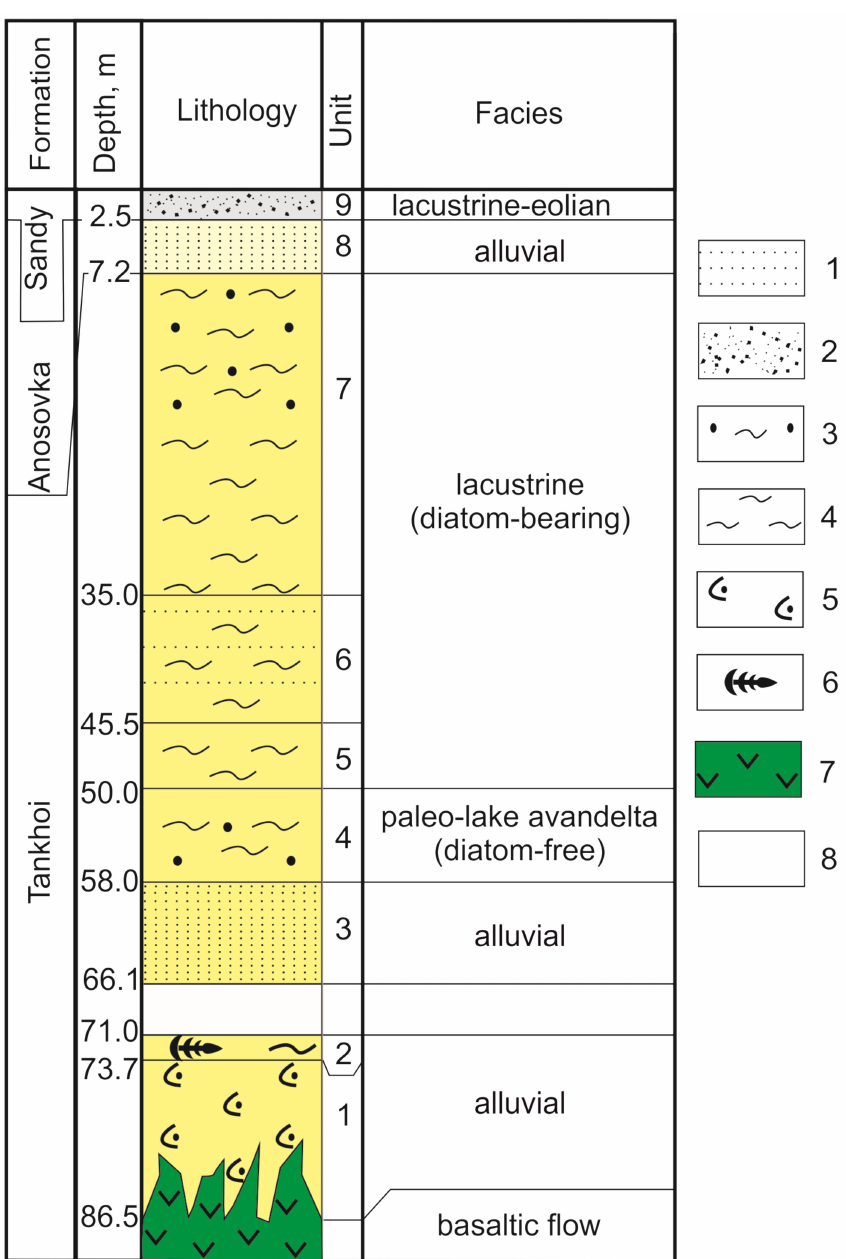
Figure 3. Stratigraphic columns of the Tunka–13 drill hole. 1—sandstone; 2—sand; 3—aleuritic sandstone; 4—aleurolite; 5—basaltic tuffites; 6—phytodetritus; 7—basalt; 8—no